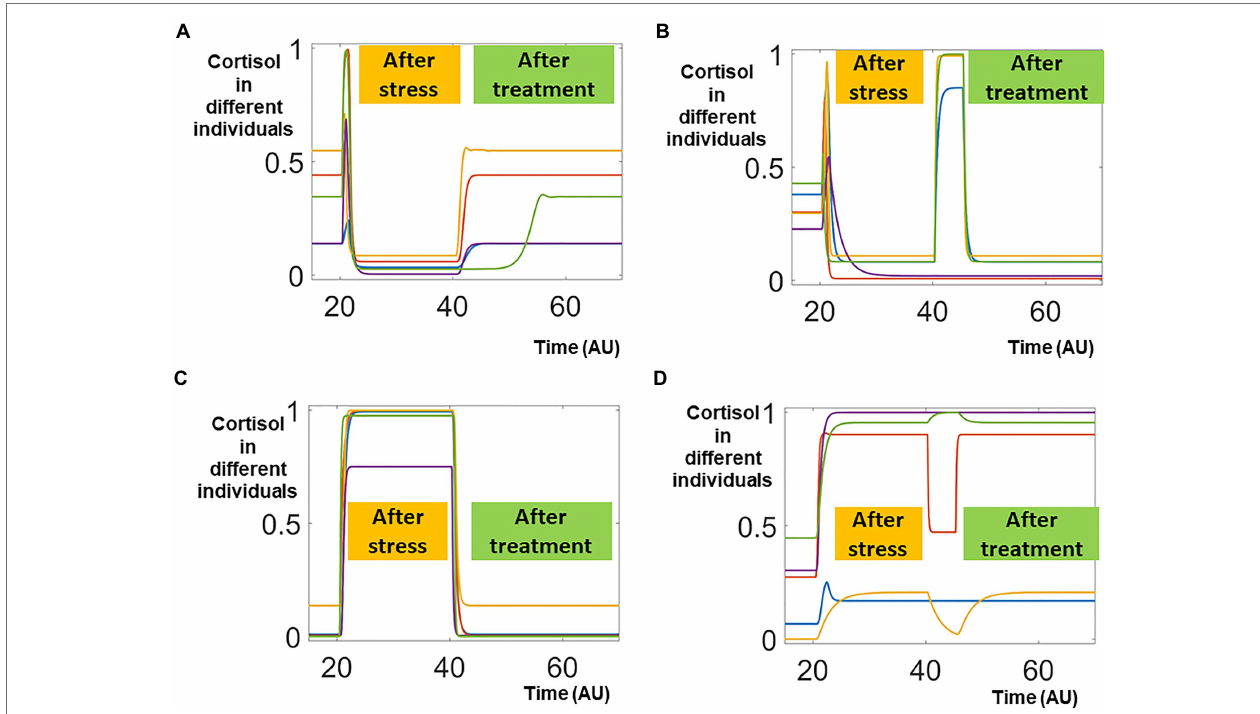
FIGURE 3 | Sampling effective and non-effective treatments. In this random scanning, one parameter is randomly perturbed around time 40. The effective treatments, which restored the cortisol distorted by the stress signal, were shown in panels (A,C) . On the other hand, the non-effective treatments, which failed to restore the cortisol levels, were shown in panels (B,D)